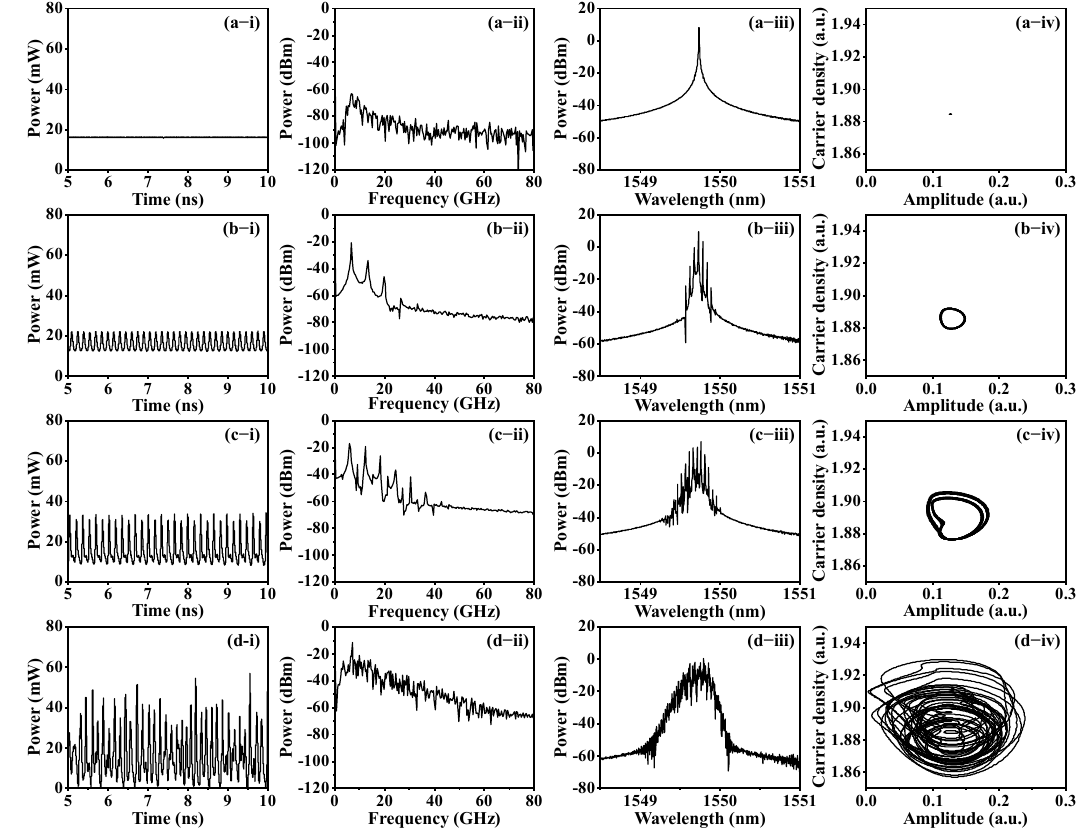
Figure 2. Various dynamic states of the MIMSL, I DFB = 2 I th , φ P1 = 0, φ P2 = π /2, when I SOA varies from top to bottoms as ( a ) 14 mA (S state); ( b ) 15 mA (P-1 state); ( c ) 17 mA (P-2 state); ( d ) 24 mA (C state). ( a-i )–( d-i ) temporal waveforms, ( a-ii )–( d-ii ) RF spectra, ( a-iii )–( d-iii ) optical spectra, and ( a-iv )–( d-iv ) phase portraits of various dynamic states, respectively.